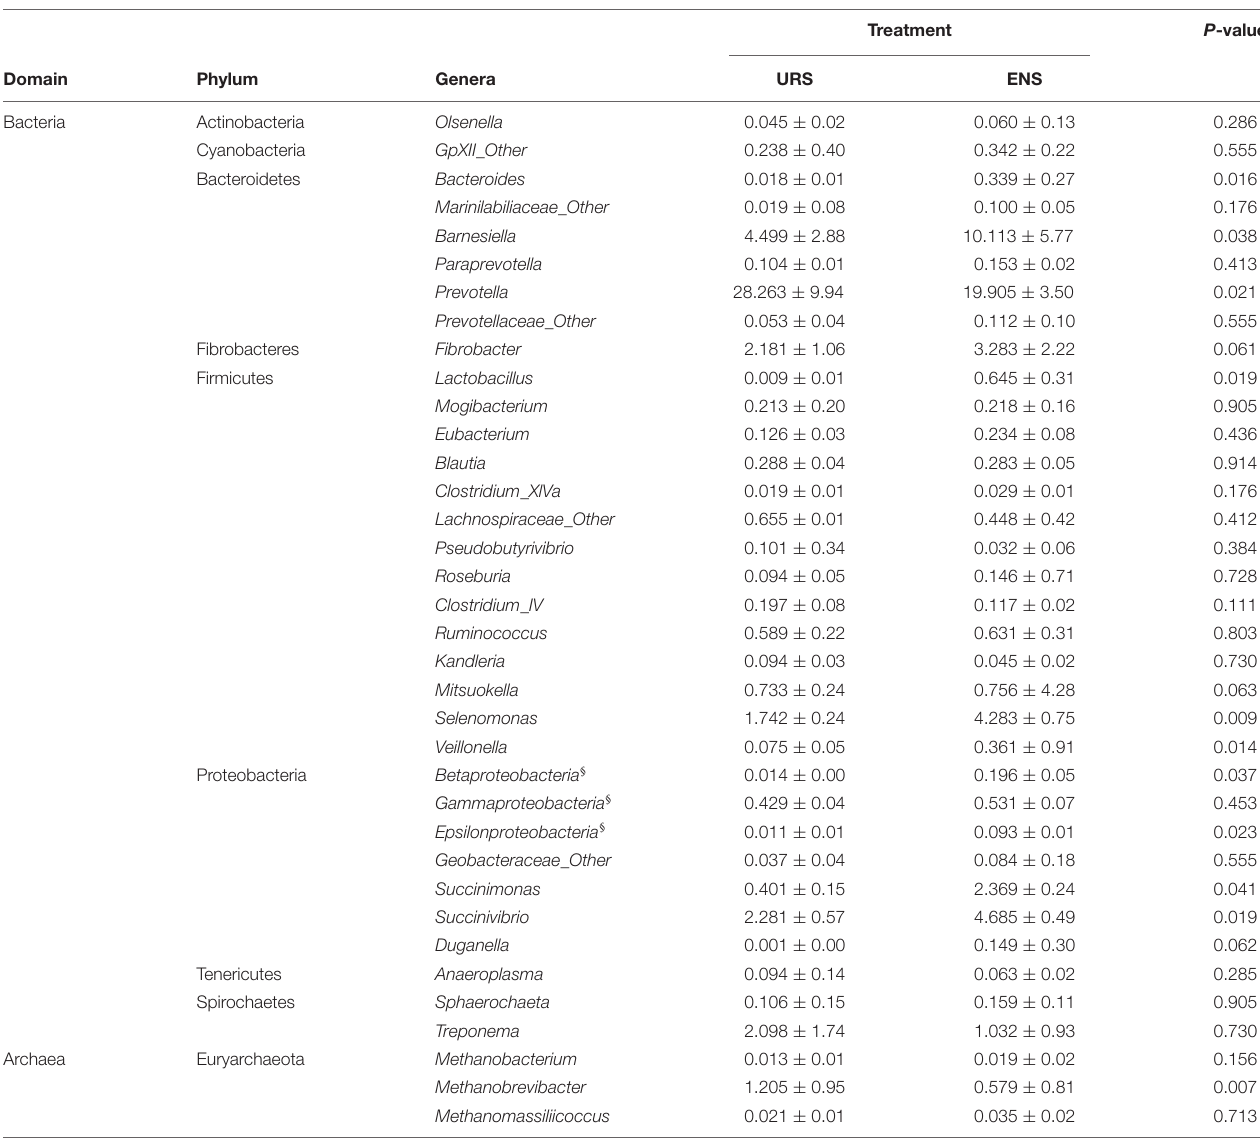
TABLE 3 | Median and interquartile range of the rumen methanogens and bacterial abundance at genera in grazing Nellore Steers after 13 months of supplementation with encapsulated nitrate (ENS) or Urea (URS).